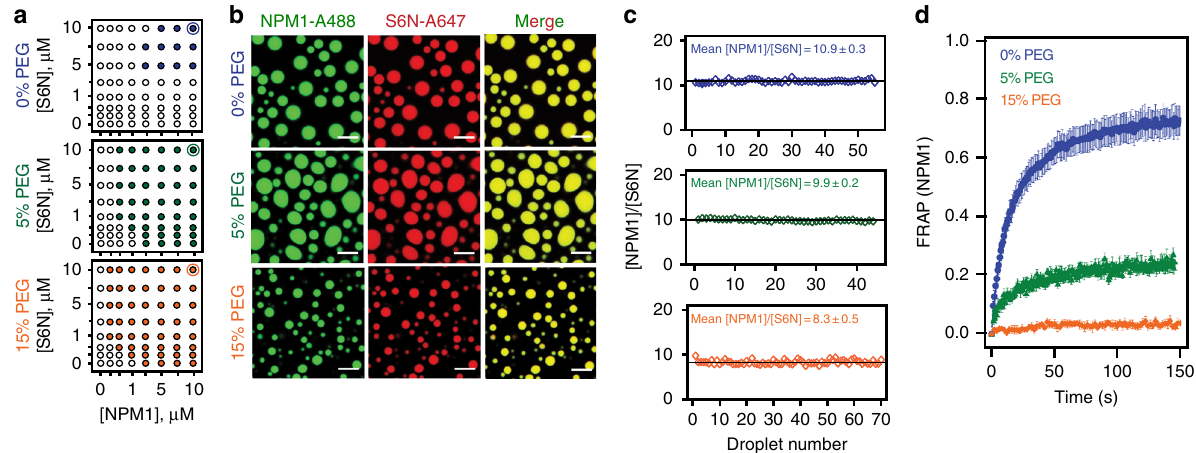
Fig. 2 Effects of macromolecular crowding on homotypic NPM1 and heterotypic NPM1-S6N LLPS. a Phase diagrams for LLPS of mixtures of NPM1 and S6N in the presence of different concentrations of PEG (0%, 5%, and 15% PEG, as indicated) determined by turbidity assays. Phase separation was not observed for protein concentrations represented by open circles (OD 340 <0.1) and was observed for those represented by solid colored circles (OD 340 ≥ 0.1). The solutions also contained 10 mM Tris, 150 mM NaCl, 2 mM DTT, pH 7.5 buffer. b Confocal microscopy images of NPM1-A488 (green) and S6N- A647 (red) droplets in the presence of different PEG concentrations (0%, top; 5%, middle; and 15%, bottom); scale bar = 10 μ m. NPM1 and S6N concentrations were 10 μ M each represented in the phase diagrams in a by thin blue, green, and orange circles around the solid circles of similar color. c Ratios of concentrations of NPM1 and S6N within individual NPM1-S6N droplets. NPM1-SURF6 molar concentration ratios ([NPM1]/[S6N]) for droplets prepared in the presence of different concentrations of PEG (0%, top panel; 5%, middle panel; or 15%, bottom panel; n ≥ 45). The black line indicates the average [NPM1]/[S6N] ratio for droplets at the speci fi ed crowding agent concentrations. In these experiments, concentrated PEG was added to pre-mixed solutions (in 10 mM Tris, 150 mM NaCl, 2 mM DTT, pH 7.5 buffer) of NPM1 and S6N to give the noted fi nal concentrations. d FRAP curves for NPM1 for NPM1-S6N droplets prepared in the presence of different PEG concentrations (0%, blue; 5%, green; or 15%, orange) after incubation for 4 h; ROI = 1 µ m circular area in the center of the droplet. Values represent mean ± s.d